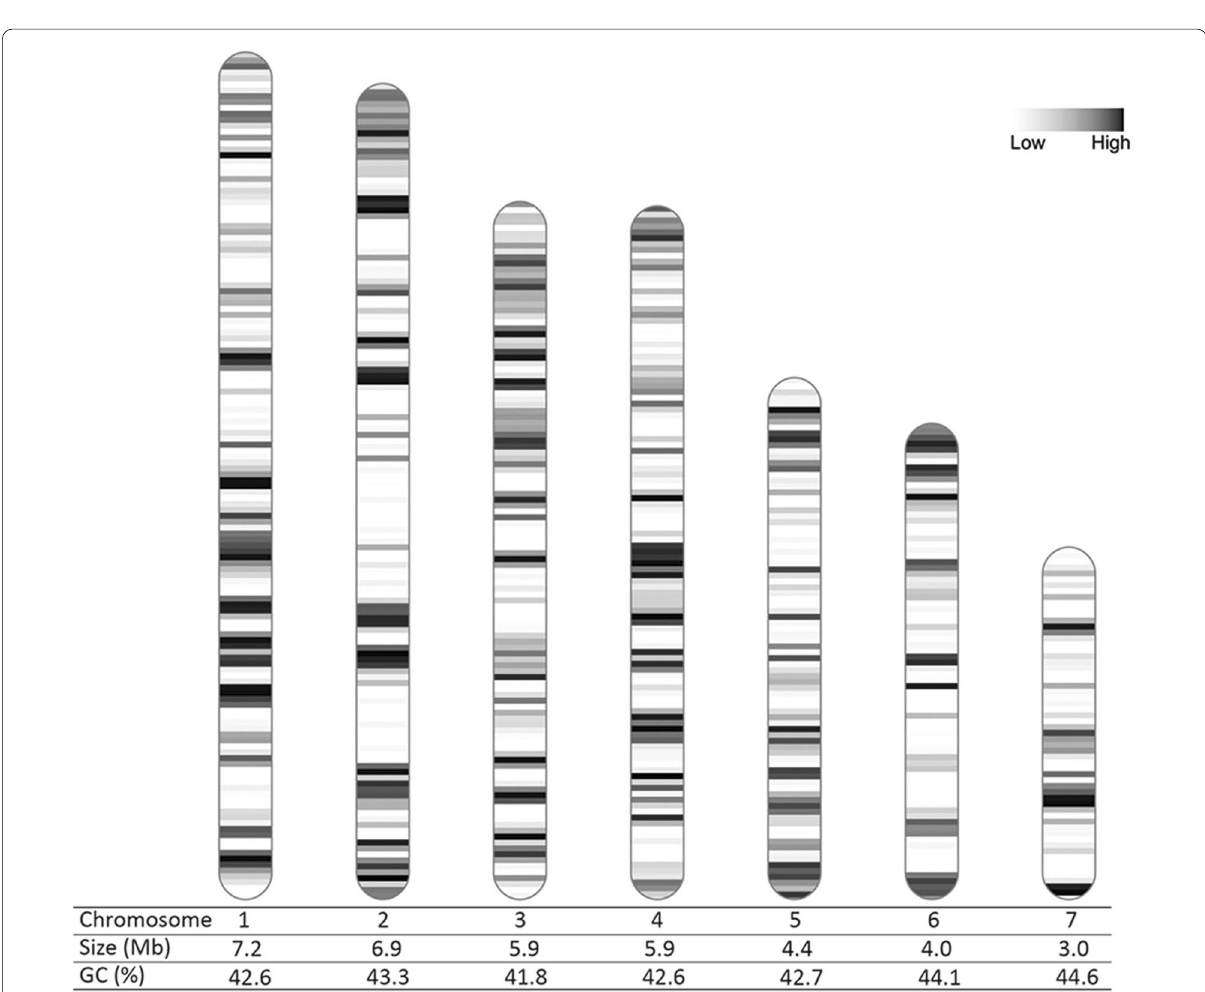
Fig. 7 Karyogram of the seven chromosomes of Epichloë scottii . Individual size and GC content is given below each chromosome. Grayscale indicates the density of repeat elements from low (white) to high